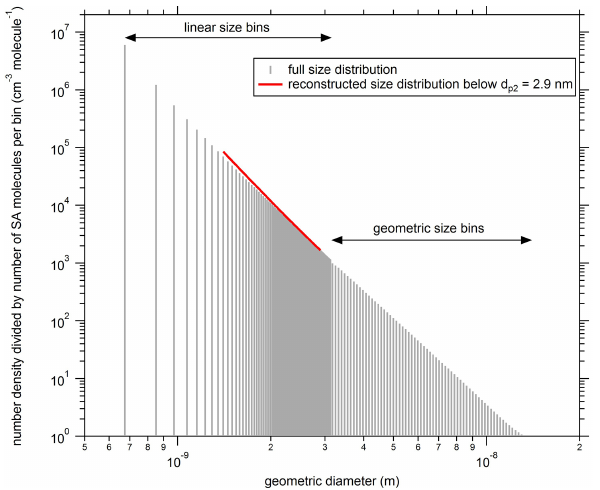
Figure 5. Formation rates as a function of particle size for kinetic nucleation. Formation rates simulated with the kinetic model are shown by the green line. Reconstructed particle formation rates starting at d p 2 = 2.9nm and ending at d p 1 = 1.4nm using a con- stant GR (taken at d p 2 ) are shown by the red